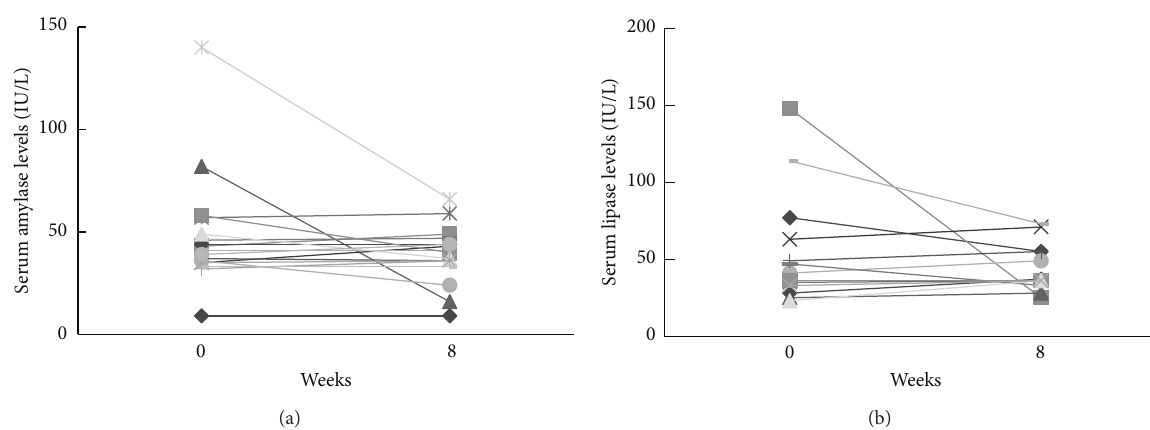
Figure 1: Serum levels of amylase and lipase at 0 and 8 weeks after low-fat ED therapy. (a) Amylase. (b) Lipase.